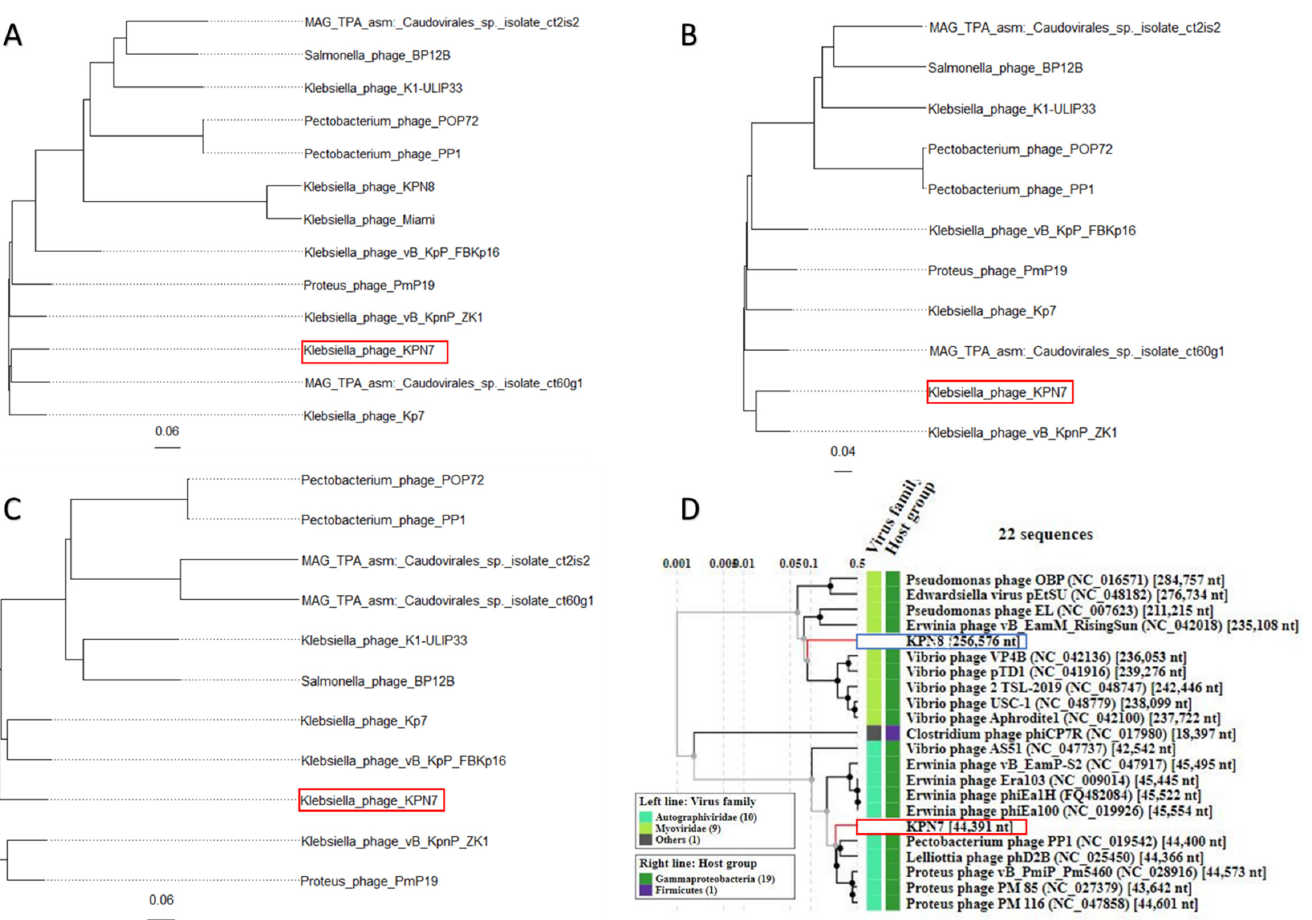
Figure 2. Phylogenetic and proteomic analysis of the bacteriophages KPN7 and KPN8 (highlighted in red and blue rectangles, respectively). Phylogenetic tree construction carried out with 100 bootstraps for putative capsid protein ( A ) putative terminase protein ( B ) and putative DNA polymerase proteins ( C ). To ascertain genomic viral taxa, viral protein analysis was constructed using VIPTree webserver ( D ).